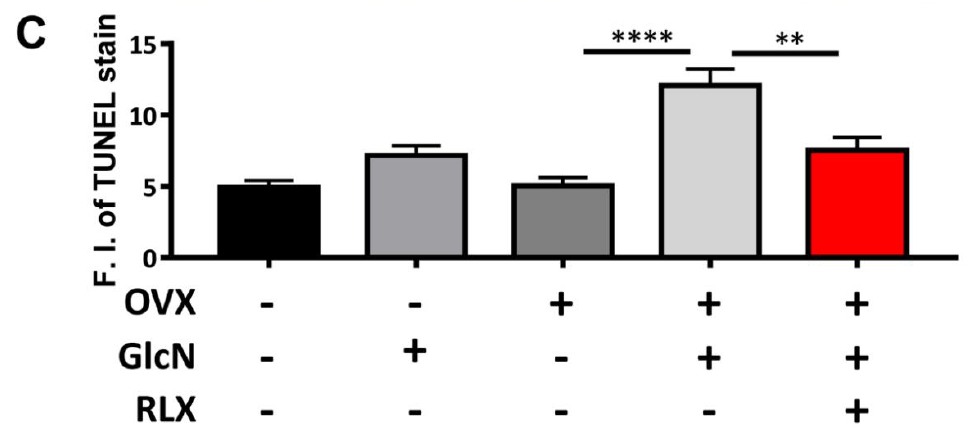
Figure 3. Islet size, immunofluorescence stains, and the quantification of insulin and TUNEL in rat pancreatic islets. The rats were randomly allocated to 5 treatments: (1) sham operation (Sham group), (2) sham with 750 mg/kg/d GlcN intraperitoneally (ip) injected for 14 days (Sham + GlcN group), (3) ovariectomy (OVX group), (4) ovariectomy with 750 mg/kg/d GlcN ip injected for 14 days (OVX+GlcN group), or (5) ovariectomy with 750 mg/kg/d GlcN ip injected for 14 days with sub- cutaneous RLX at 0.5 mg/kg/d. ( n = 8 in each group). ( A ) The size of pancreatic islets of all groups. Pancreatic islets were nearly the same size in the Sham and Sham + GlcN groups. The size of the pancreatic islets markedly increased in the OVX group and increased further in the OVX+GlcN group, suggestive of islet hyperplasia compensating for IR. RLX treatment significantly reduced the size of the pancreatic islets in the OVX+GlcN rats to nearly the size in the OVX group. (Scale bar = 50 µ m) ( B ) Immunofluorescence stains for TUNEL and insulin in pancreatic islets of all groups. Ovariectomy and GlcN reduced the immunofluorescence staining intensity for insulin in pancreatic islets; this intensity further decreased in the OVX+GlcN group. Treatment with RLX in OVX+GlcN rats increased the stain- ing intensity of insulin. No difference was present among the OVX, GlcN, and Sham groups in apoptotic cell proportions as determined through TUNEL staining. (Scale bar = 50 µ m) ( C ) Quantification of im- munofluorescence stains for TUNEL in rat pancreatic islets. No difference existed among the OVX, GlcN, and Sham groups in the proportions of apoptotic cells. The proportion of apoptotic cells increased signifi- cantly in the OVX+GlcN group (12.09% ± 1.17%), whereas RLX reduced the proportion of apoptotic